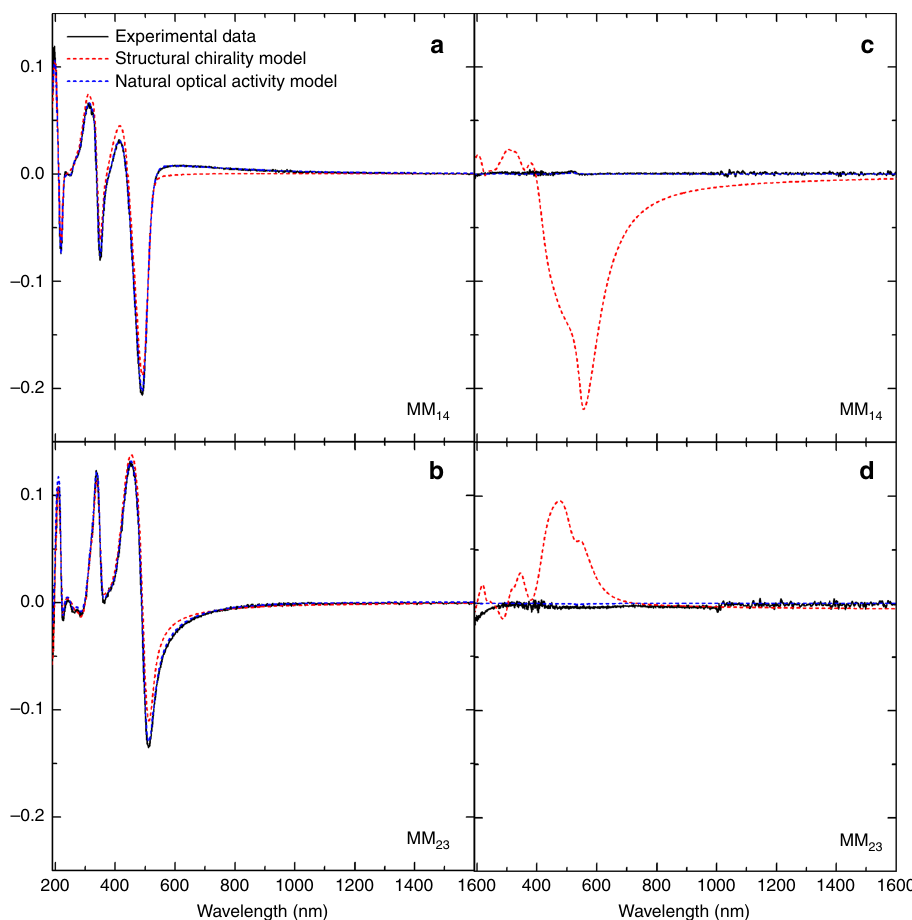
Fig. 3 Experimental and modelled MM data for non-aligned ACPCA thin fi lms. Measured MM data (black solid line) associated to CD (M 14 ) and CB (M 23 ) recorded in transmission ( a , b ) and re fl ection ( c , d ) along with a model-calculated match to the MM transmission and re fl ection data for a 131 nm thick non-aligned F8BT:aza[ M ]H fi lm assuming the origins of the chiroptical effect are structural chirality (red dashed line) or natural optical activity (blue dashed